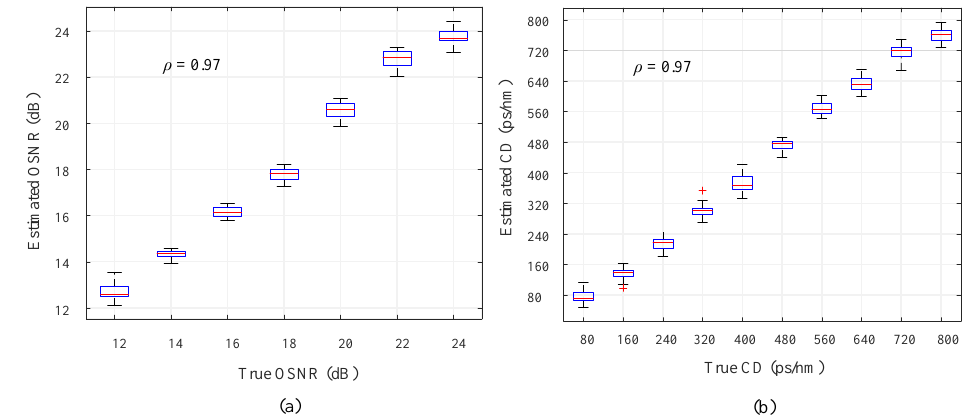
Figure 16. Experimental setup of the proposed OPM in super-channel networks. LD: laser diode, AWG: arbitrary waveform generator, RF: radio frequency, PM: phase modulator, EDFA: Erbium- doped fiber amplifier, VOA: variable optical attenuator, OSNR: optical signal-to-noise ratio, OBPF: optical band pass filter, OC: optical coupler, LO: local oscillator.